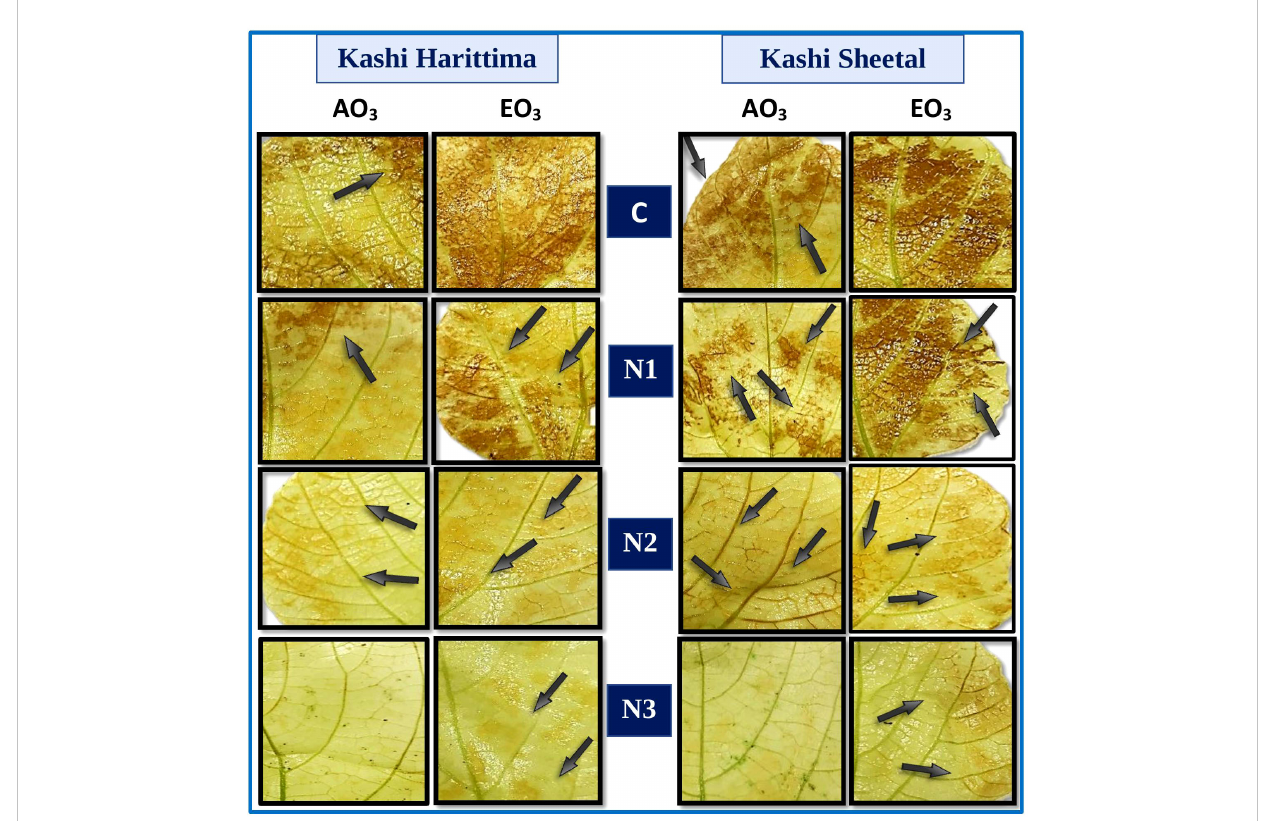
FIGURE 4 Histochemical localization of hydrogen peroxide (H 2 O 2 ) stained with DAB (brown color) in two varieties of Dolichos lablab L. exposed to AO 3 and EO 3 under different nitrogen fertilization